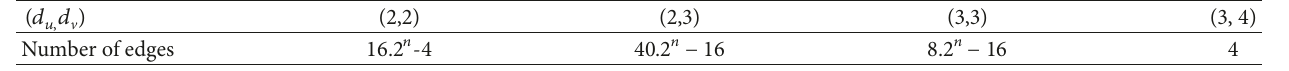
Table 3: Edge partition of Zinc-Porphyrin dendrimers based on degree of end vertices of each edge.